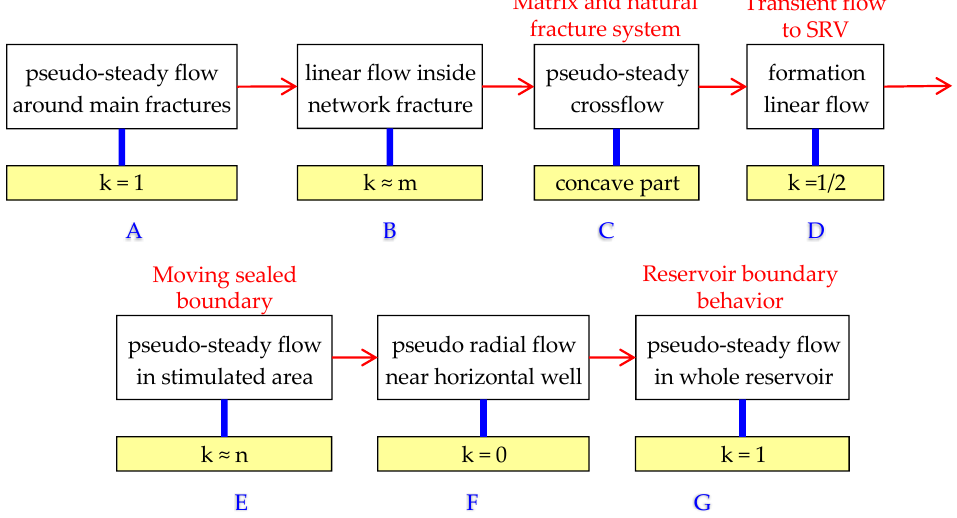
Figure 6. Flow regimes division during SRV-fractured horizontal well production in tight oil reservoir.